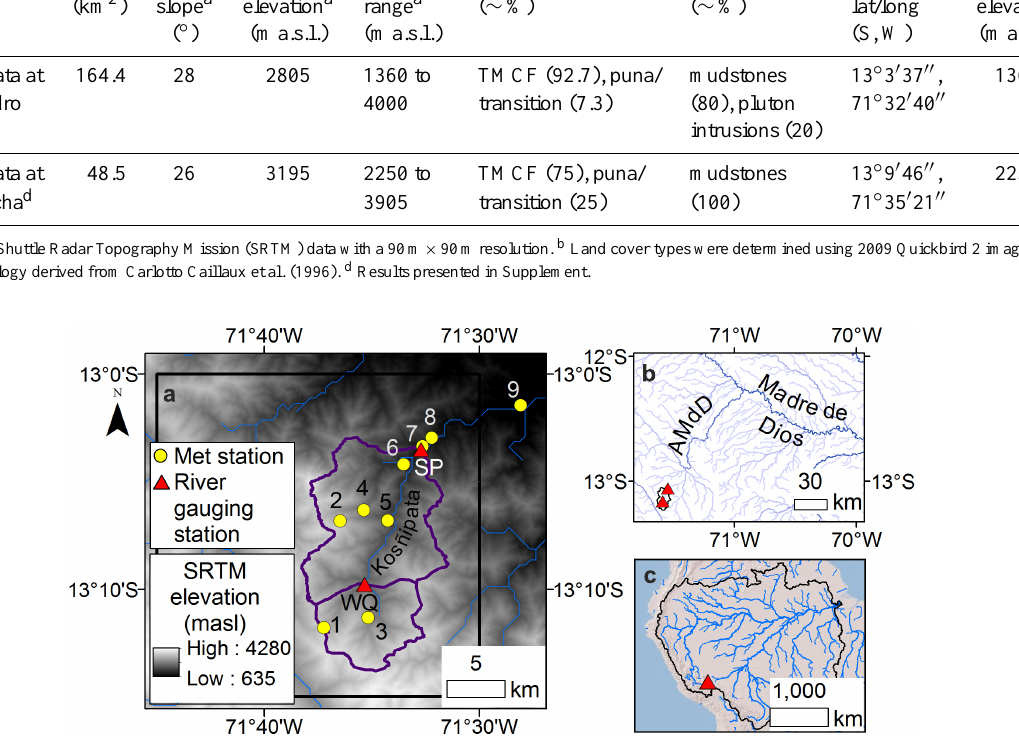
Figure 1. (a) The Kosñipata catchment, eastern Andes of Peru, showing the Kosñipata River catchment measured at the San Pedro (SP) river gauging station and the nested sub-catchment at the Wayqecha (WQ) river gauging station, overlaid on 90m × 90m digital elevation model (Shuttle Radar Topography Mission) (Farr et al., 2007). Black box indicates the extent of the TRMM 3B43 tile used in this study (cf. Fig. 2a). The meteorological stations used for rainfall data are numbered 1 to 9 (Table S2). (b) The Kosñipata River flows into the Alto Madre de Dios (AMdD) and then into the Madre de Dios River, a major tributary of the Amazon River (c) . The river network was produced from HydroSHEDS (Hydrological data and maps based on SHuttle Elevation Derivatives at multiple Scales) (Lehner et al.,